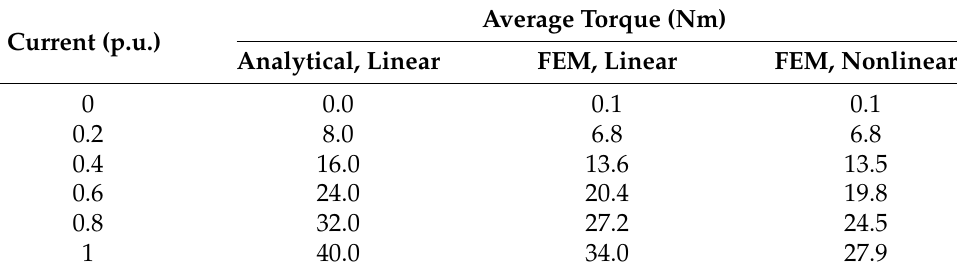
Table 8. Analytical an FEM average